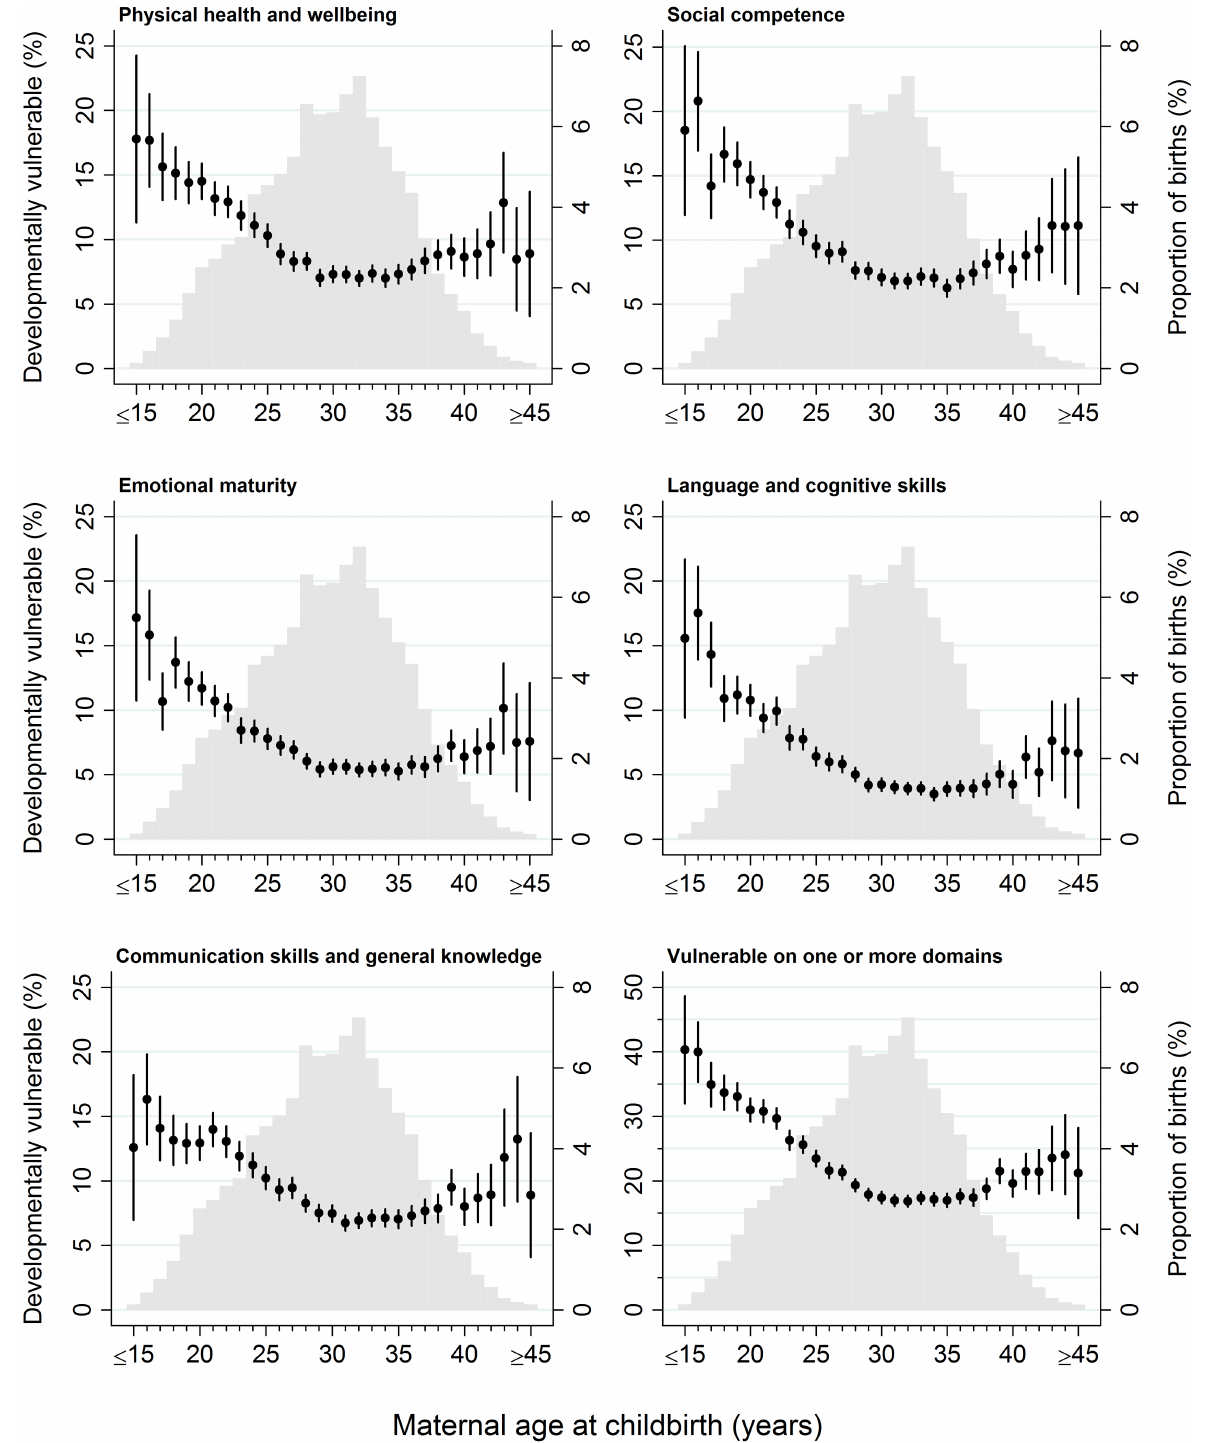
Fig 1. The distribution of maternal age at childbirth for children in the study population, overlaid with the proportion of children who were developmentally vulnerable on each outcome, by maternal age at childbirth. Light grey columns, study population birth distribution by year of maternal age at childbirth; black point estimates with 95% CIs, proportion of children developmentally vulnerable on each outcome (specified in figure subtitle).